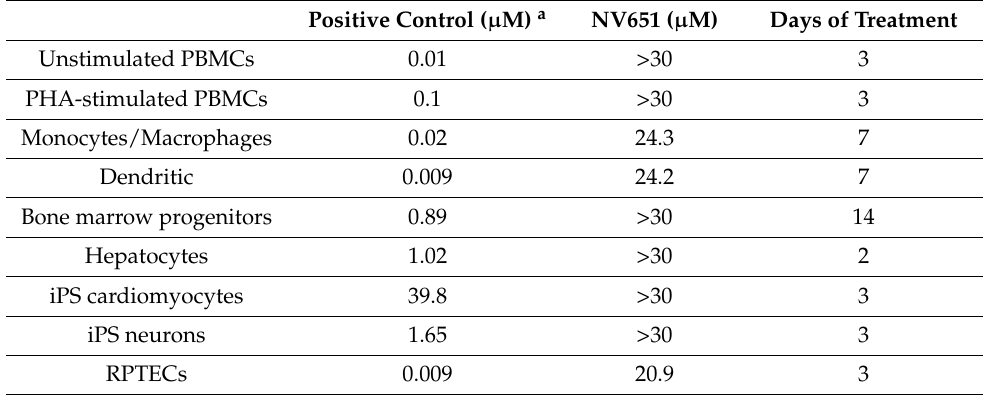
Table 1. NV651 toxicity in normal cells. (A) IC 50 values for NV651 and positive controls in various normal human cell lines. (B) NV651 MEC and AC 50 values in primary human hepatocytes evaluated for several health parameters.